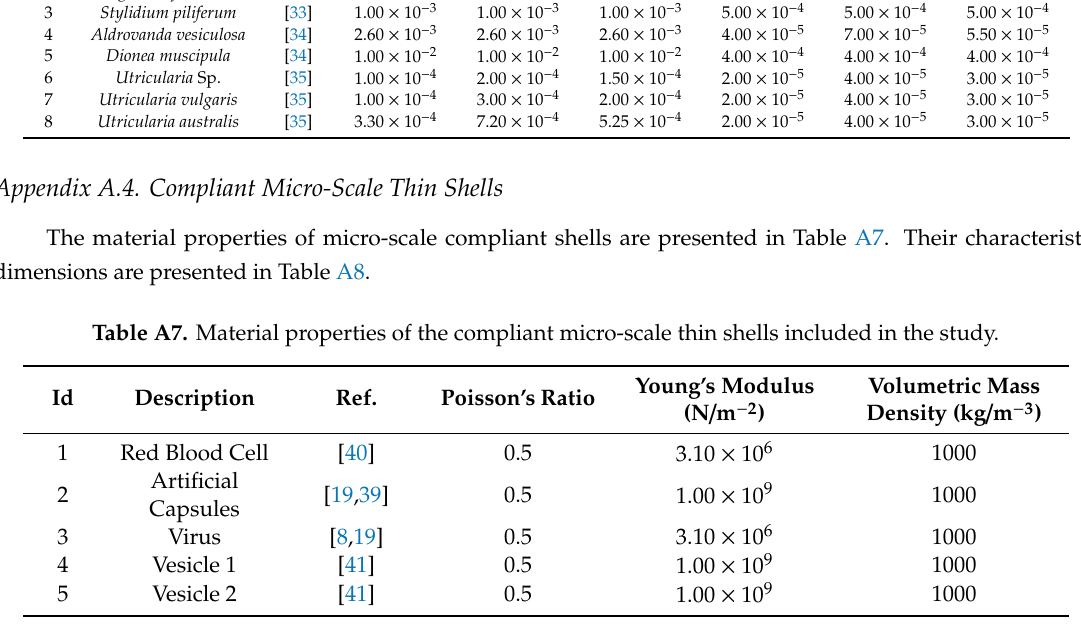
Table A8. Dimensions of the compliant micro-scale thin shells included in the study.